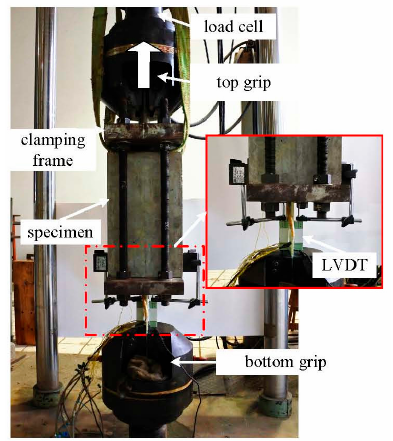
Figure 4. Test set-up (MTS, Shanghai, China).